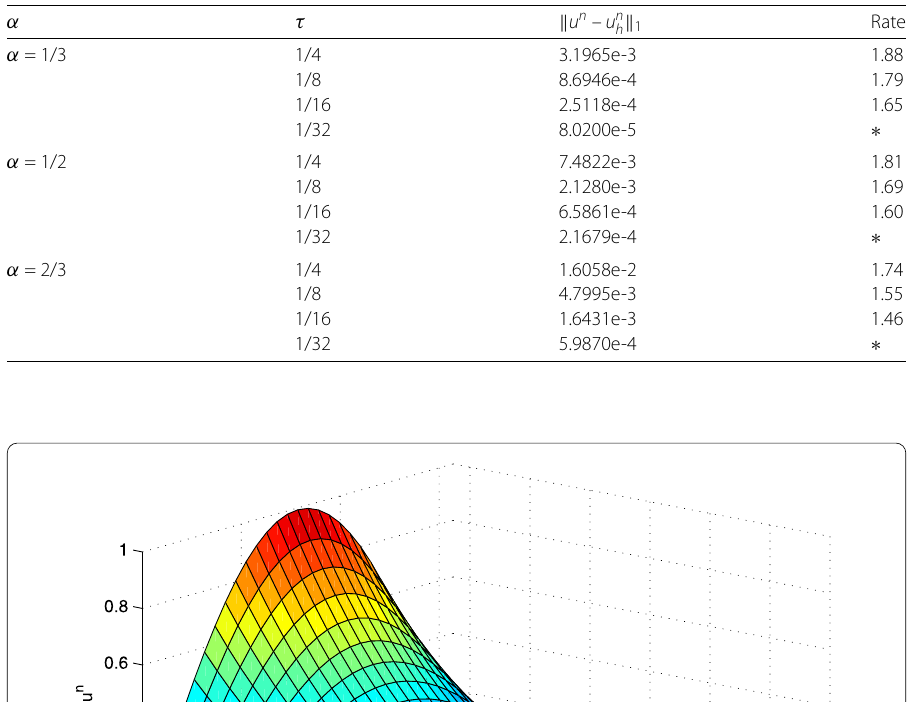
Table 8 Numerical errors and convergence orders in temporal direction with h = π T = 1 for Example 2